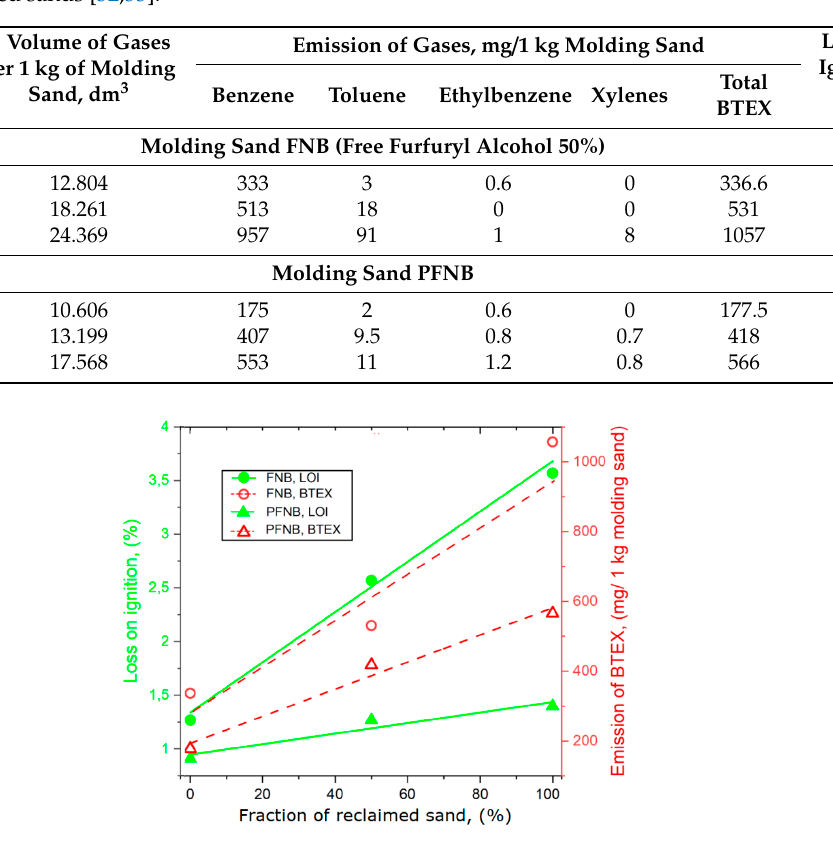
Table 6. Concentration of BTEX formed during thermal decomposition of molding sand (FNB and PFNB) with reclaimed sands [32,33].